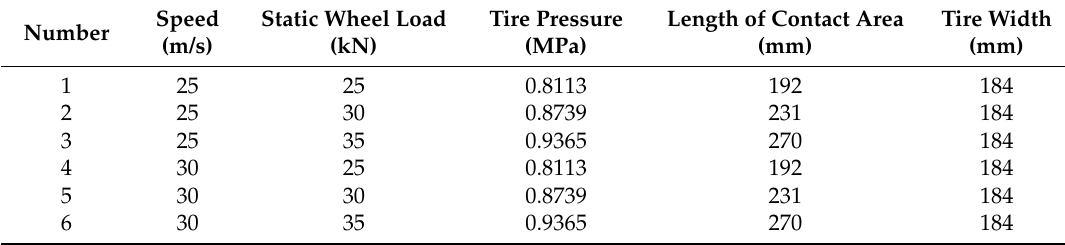
Figure 7. Moving load on the pavement. ( a ) Load movement method; ( b ) The position of the moving load on the pavement. Table 2. Parameters of Vehicle load models.